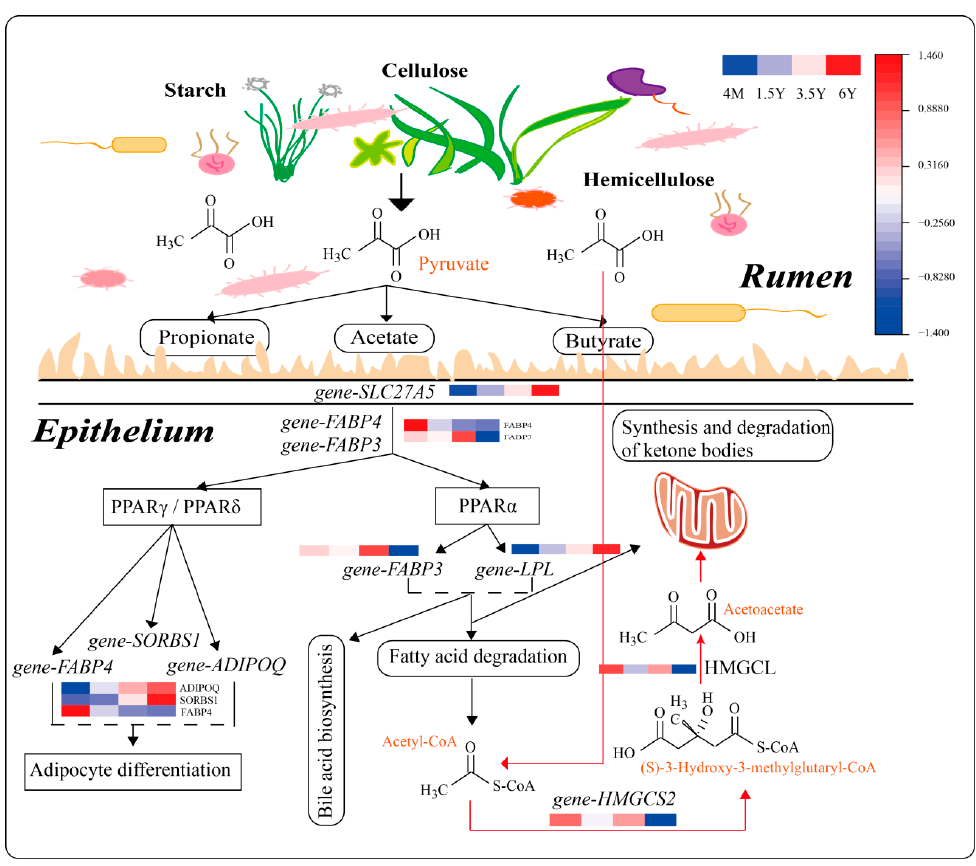
Figure 9. PPAR signaling pathway. Note: The heat map in the pathway represents gene expression at four ages and the redder the color, the higher the gene expression.